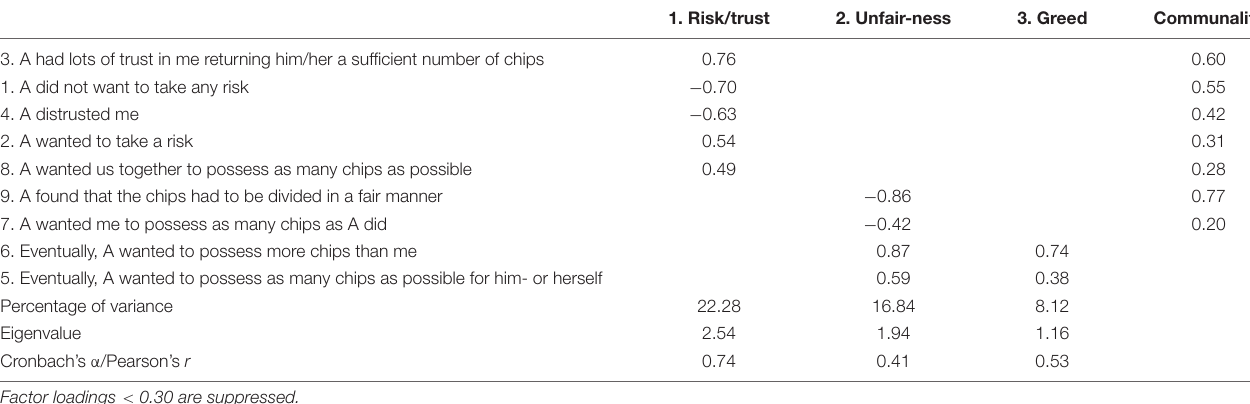
TABLE 7 | Factor loadings based on an exploratory factor analysis with a principal axis factoring and direct oblimin rotation on nine items measuring the perceived underlying motives ( N = 140).